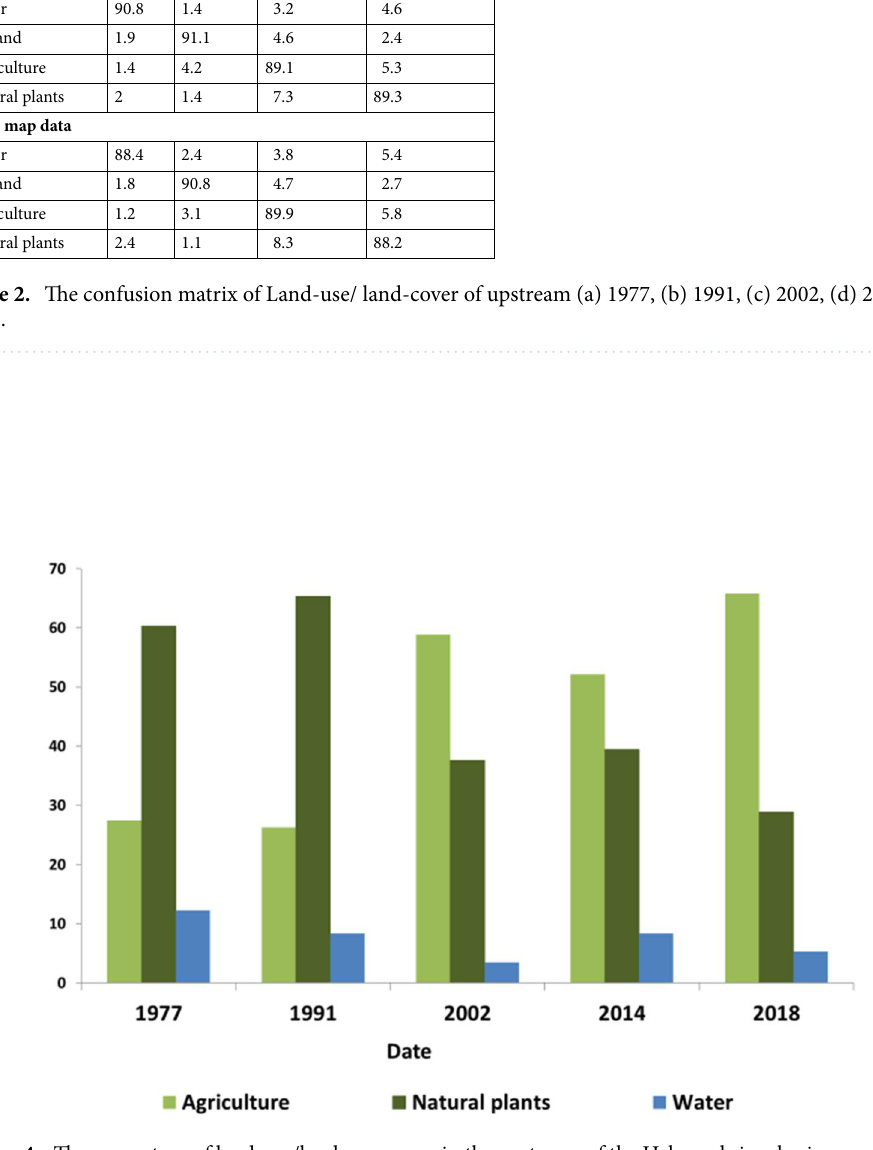
Figure 4. The percentage of land-use/land-cover area in the upstream of the Helmand river